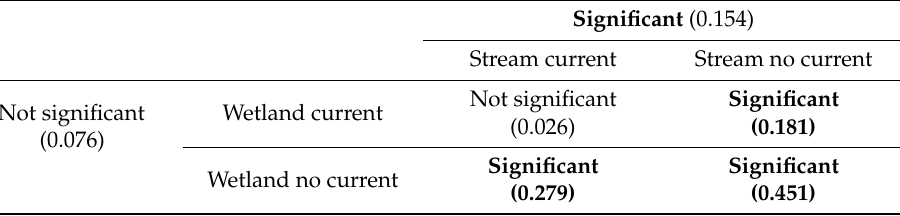
Table 1. Results of pairwise two-way ANOSIM examining similarities and dissimilarities in head morphologies of captive G. gollumoides within the four experimental treatments, based on the mean relativised standard length standardised morphological variables used to construct the Euclidean distance matrix underlying the head MDS. Significant and Not significant—treatments significantly and not significantly di ff erent at p < 0.05, respectively. ANOSIM R values for each pairwise test are given in